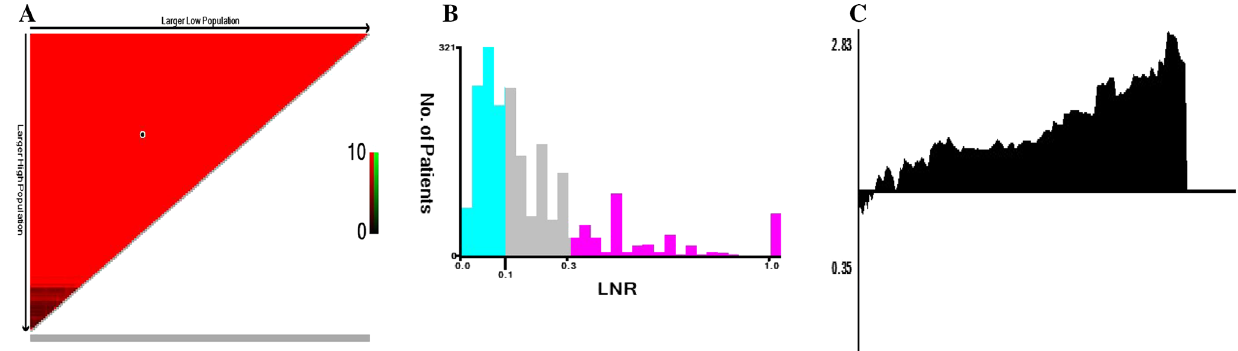
Fig. 4 The best cut-off values for the lymph node ratio (LNR) by using X-tile. A The cut-point for the entire queue. B The histogram of the entire cohort. C The relative risk (RR) of the entire queue